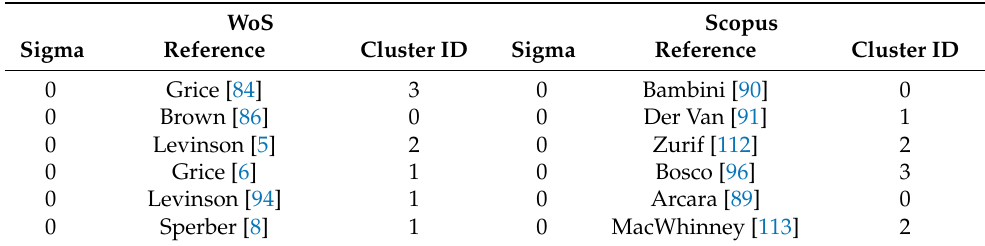
Table 6. Bursts detection for research on pragmatics. WoS Scopus Table 8. Sigma calculation for top 10 authors in pragmatics. Burst WoS Scopus Sigma Reference Cluster ID Sigma Reference Cluster